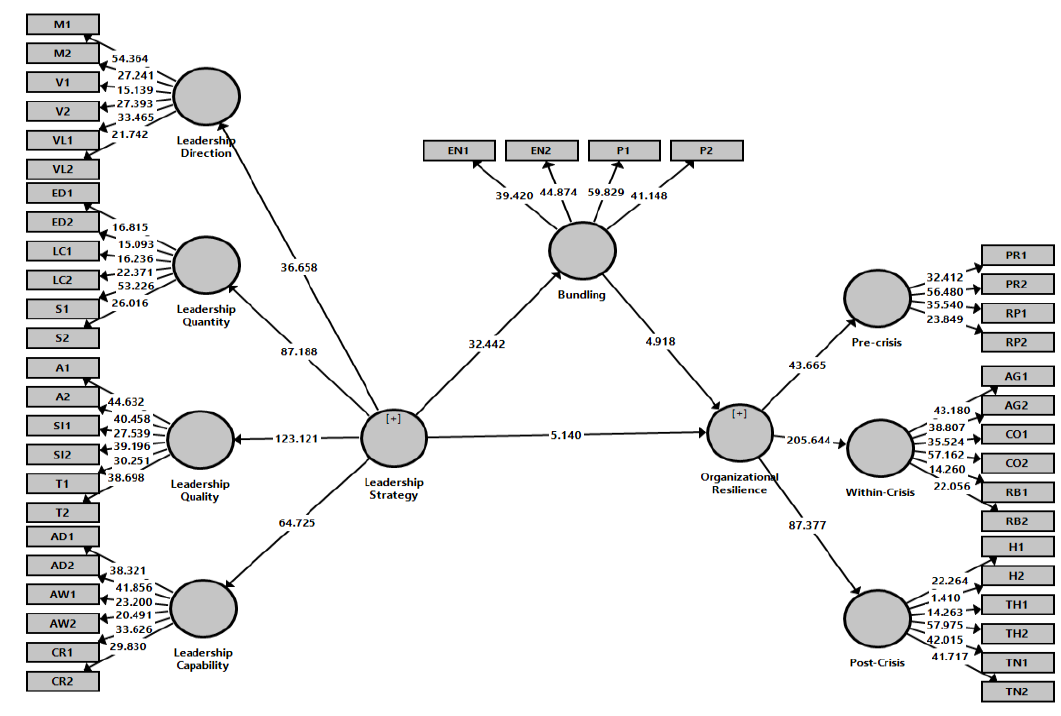
Figure 6: Model Path Coefficients of Resource Bundling